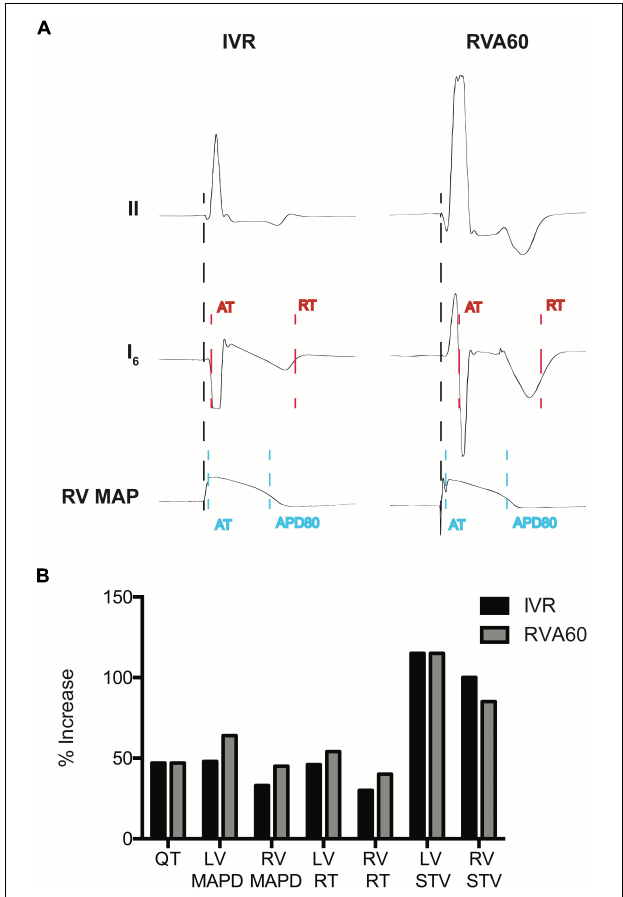
FIGURE 1 | Measurement of electrophysiological parameters and the percentage (%) increases of electrophysiological parameters following infusion of dofetilide in the serially performed IVR and RVA60 experiments. (A) Representative beats from lead II, a left ventricular (LV) intraventricular electrogram (EGM) and a right ventricular (RV) monophasic action potential (MAP) in IVR and RVA experiments. Start of activation (black dashed line) was determined at the start of the QRS complex (IVR experiments) or pacing spike (RVA experiments) in lead II. LV activation time (AT) was measured as the time between start of ventricular activation and the steepest downslope of the EGM (red dashed line), whereas LV repolarization time (RT) was measured at the steepest upslope (red dashed line). LV activation recovery interval (ARI) was measured as LV, RT – LV, AT. RV, AT was measured from the start of ventricular activation to the upstroke of the RV MAP (blue dashed line). Monophasic action potential duration (MAPD) was determined at 80% of repolarization (blue dashed line). (B) The percentage in electrophysiological parameters representing repolarization time and stability following infusion of dofetilide in the serially performed IVR and RVA60 experiments. IVR, idioventricular rhythm; LV/RV MAPD, left/right ventricular monophasic action potential duration; LV/RV RT, left/right ventricular repolarization time; LV/RV STV, left/right ventricular short-term variability; RVA60, right ventricular apex paced at 60 beats per